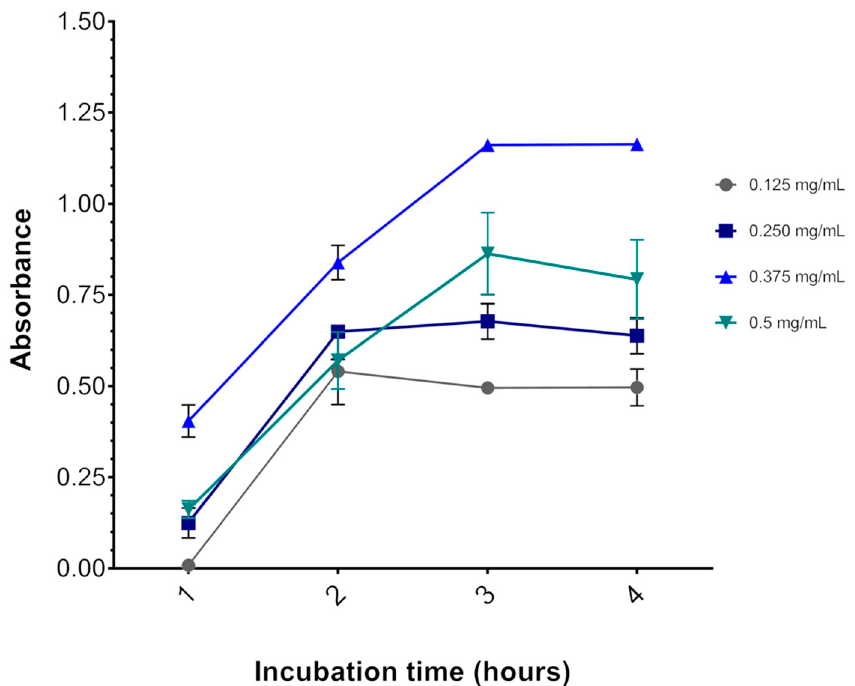
Figure 3. Effect of MTT concentration and incubation time on the U87 cell line. The graph represents the values of the absorbances as a function of incubation time. After 3 h of incubation at 37 °C, the absorbance reaches a plateau. The colored lines represent the MTT salt concentrations (gray = 0.125, dark blue = 0.250, light blue = 0.325, and green = 0.5 mg/mL MTT salt). Data are expressed as mean ± standard deviation. Representative graphs of three independent experiments performed in triplicate.